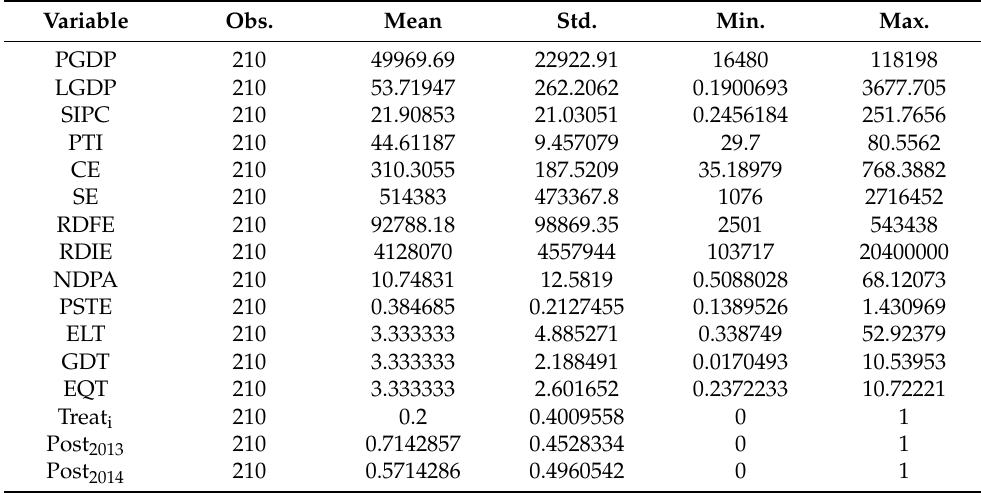
Table 2. Descriptive statistics of all